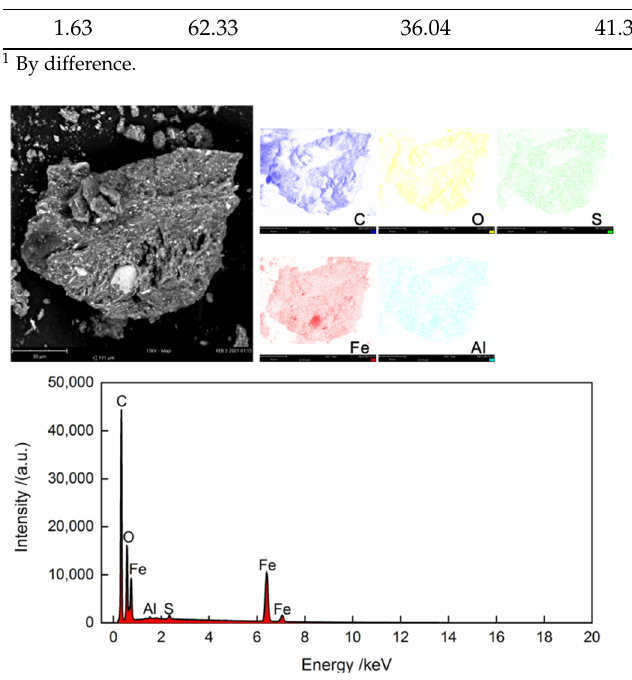
Figure 1. SEM images and EDS spectra of the dried cold-rolling oily sludge. Table 3. Element analyses of the solid phase in the cold-rolling oily sludge by XRF (wt %).